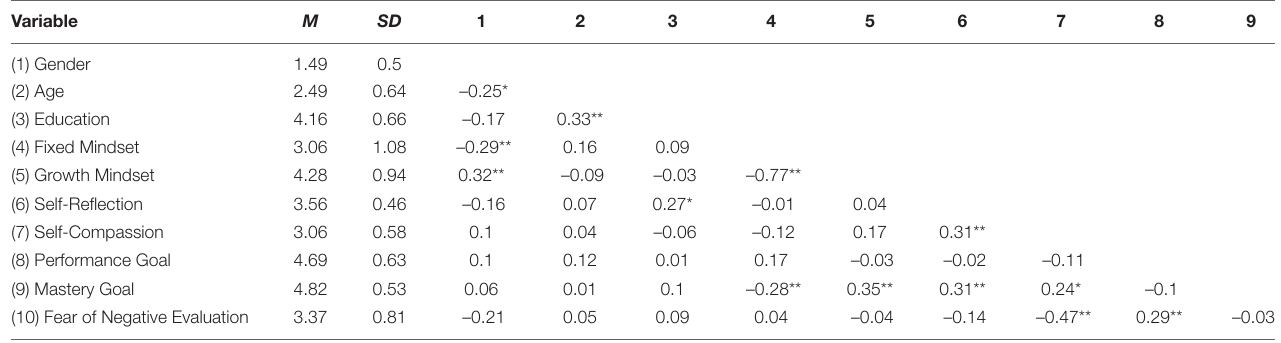
TABLE 2 | Correlations for Study 1 ( N = 88).